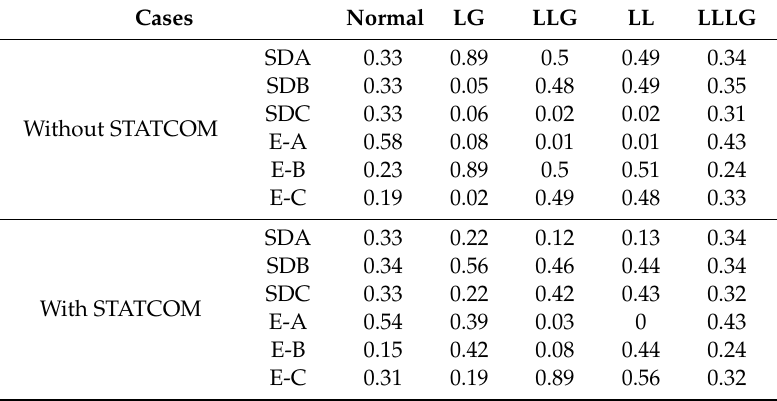
Table 2. Conditional Probability for the proposed